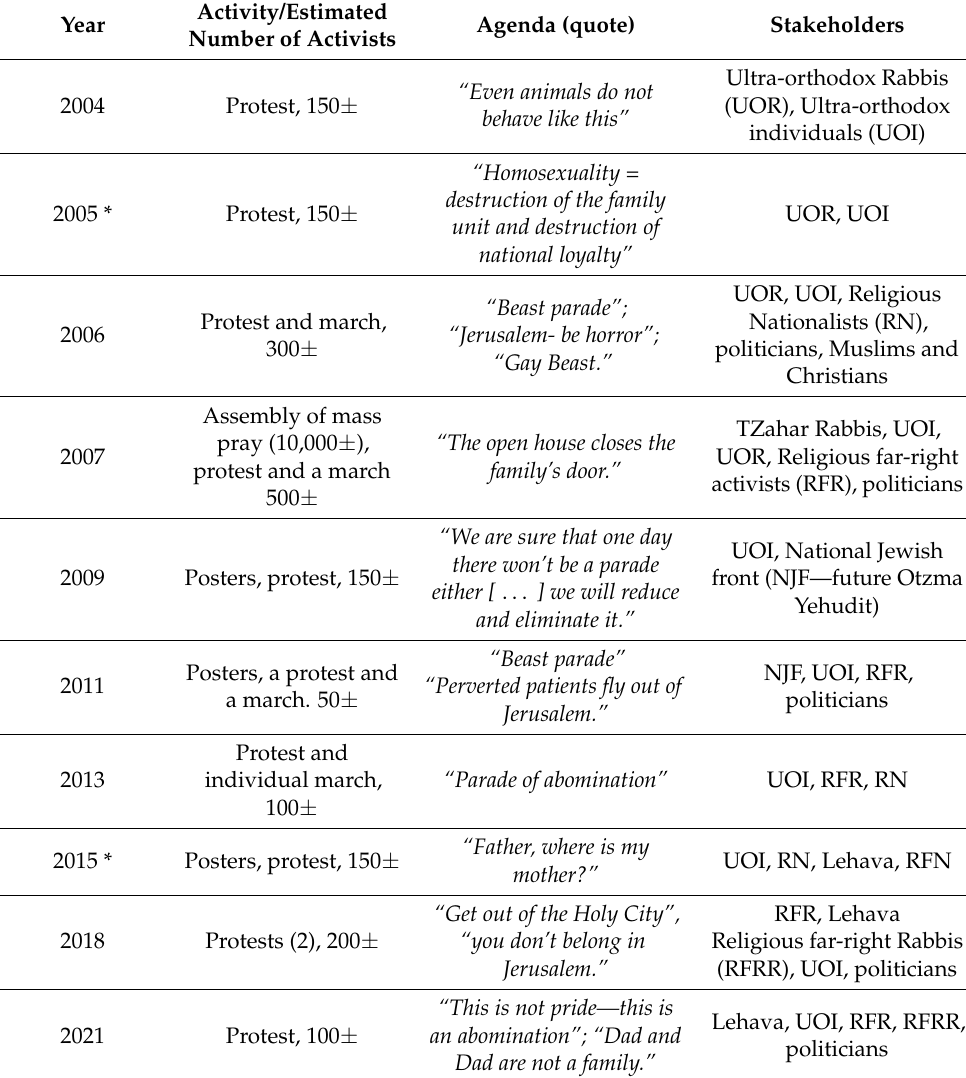
Table 1. Radicalisation in The Pride